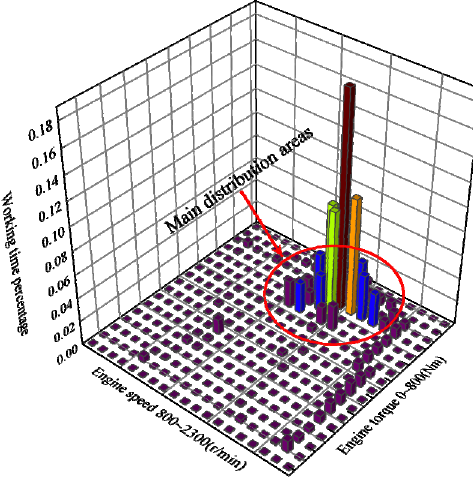
Figure 21. Engine working time percentage distribution.